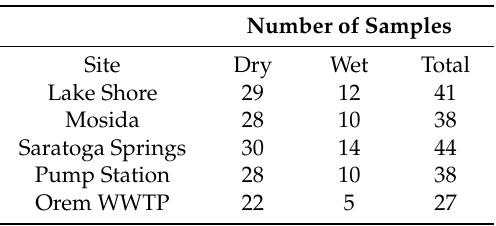
Table 2. Number of dry and wet samples collected at each